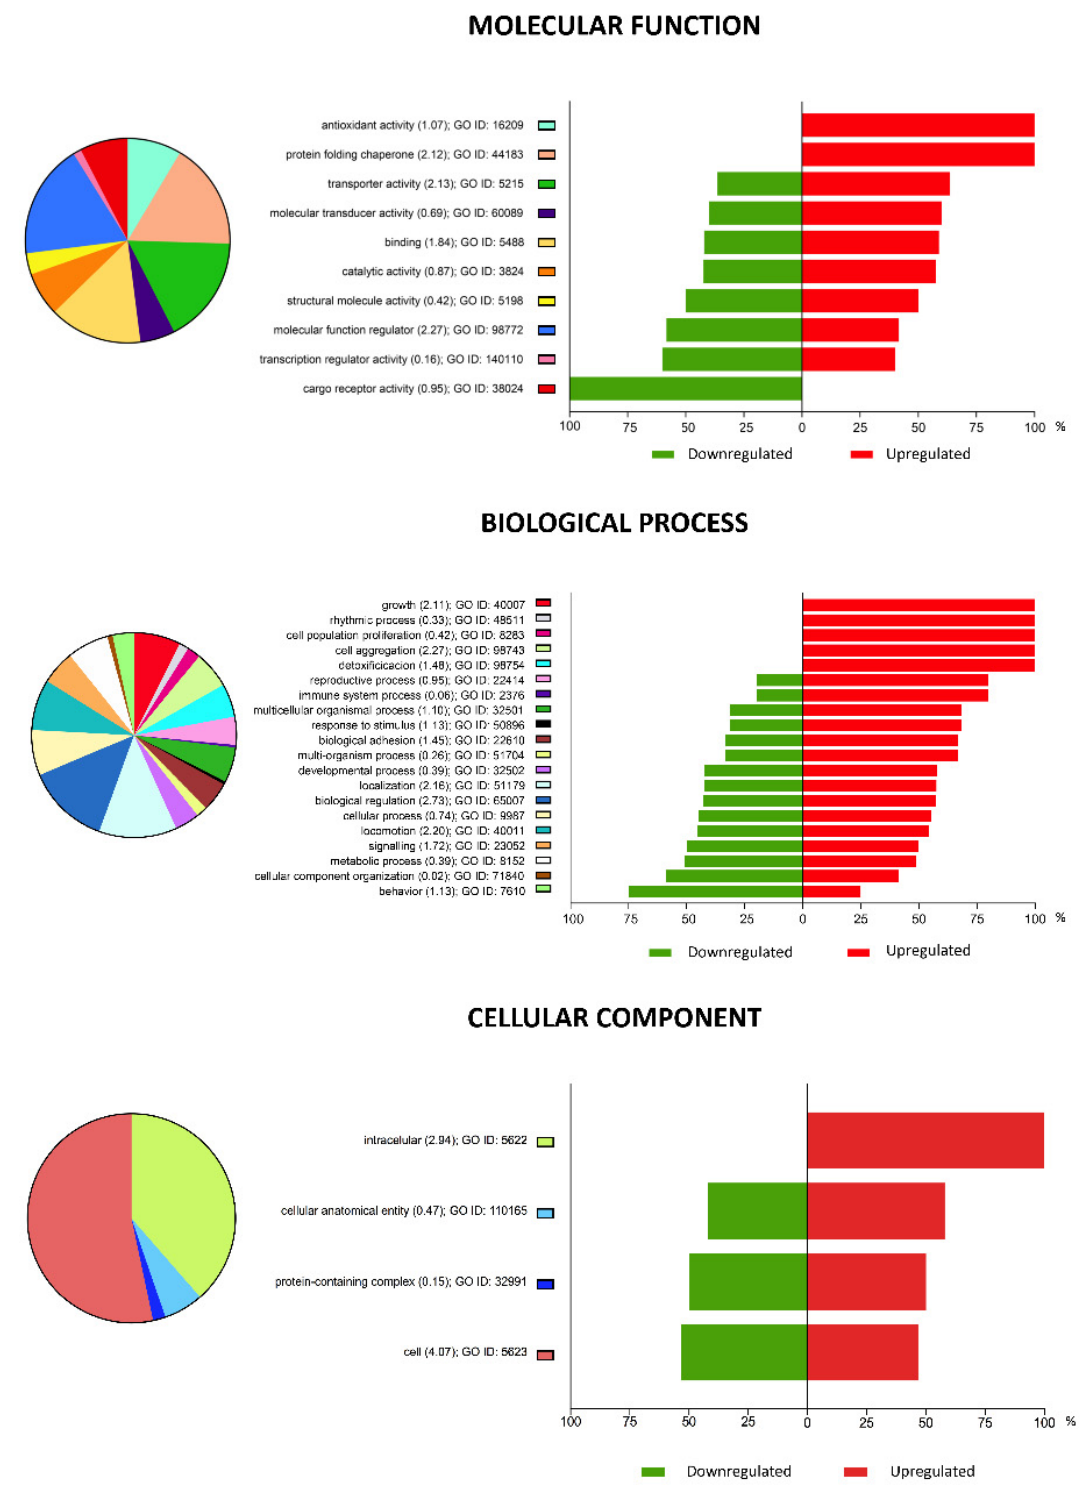
Figure 3. Pie chart representation of Gene Ontology (GO) terms for differentially expressed genes (DEGs) in vitrified blastocysts analyses, summarized according to molecular function, biological processes, and cellular component. The plots show the percentage of genes associated with each functional group that were upregulated (red) or downregulated (green). Functional categories of DEGs were obtained using GO annotations from the KEGG classification system. Numbers within parentheses indicate enrichment scores.